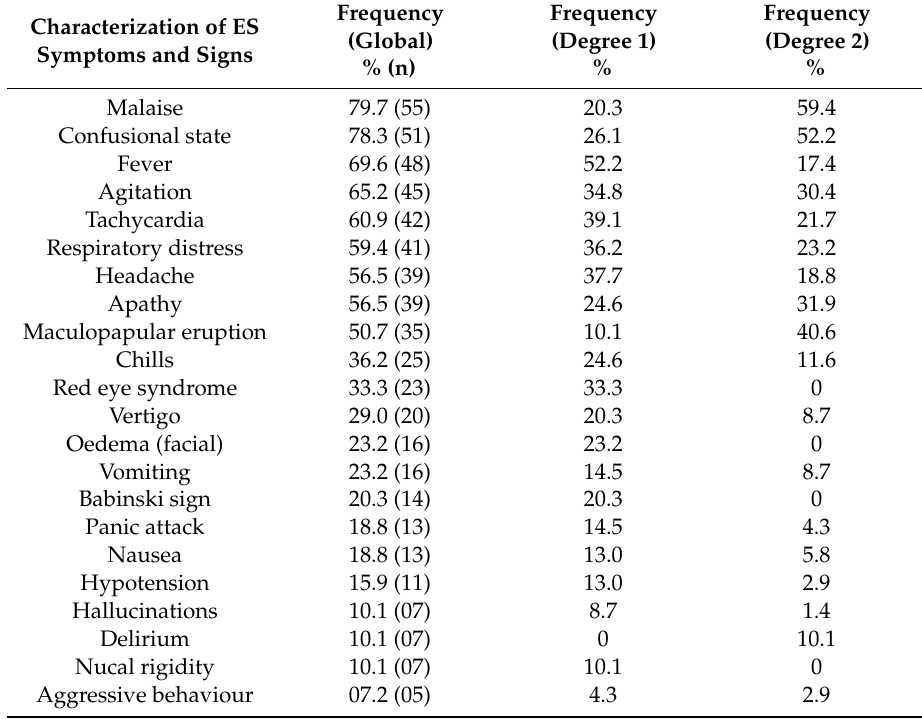
Table 3. Symptoms and signs characterizing ES, according to the global frequency and discriminated for the degree of